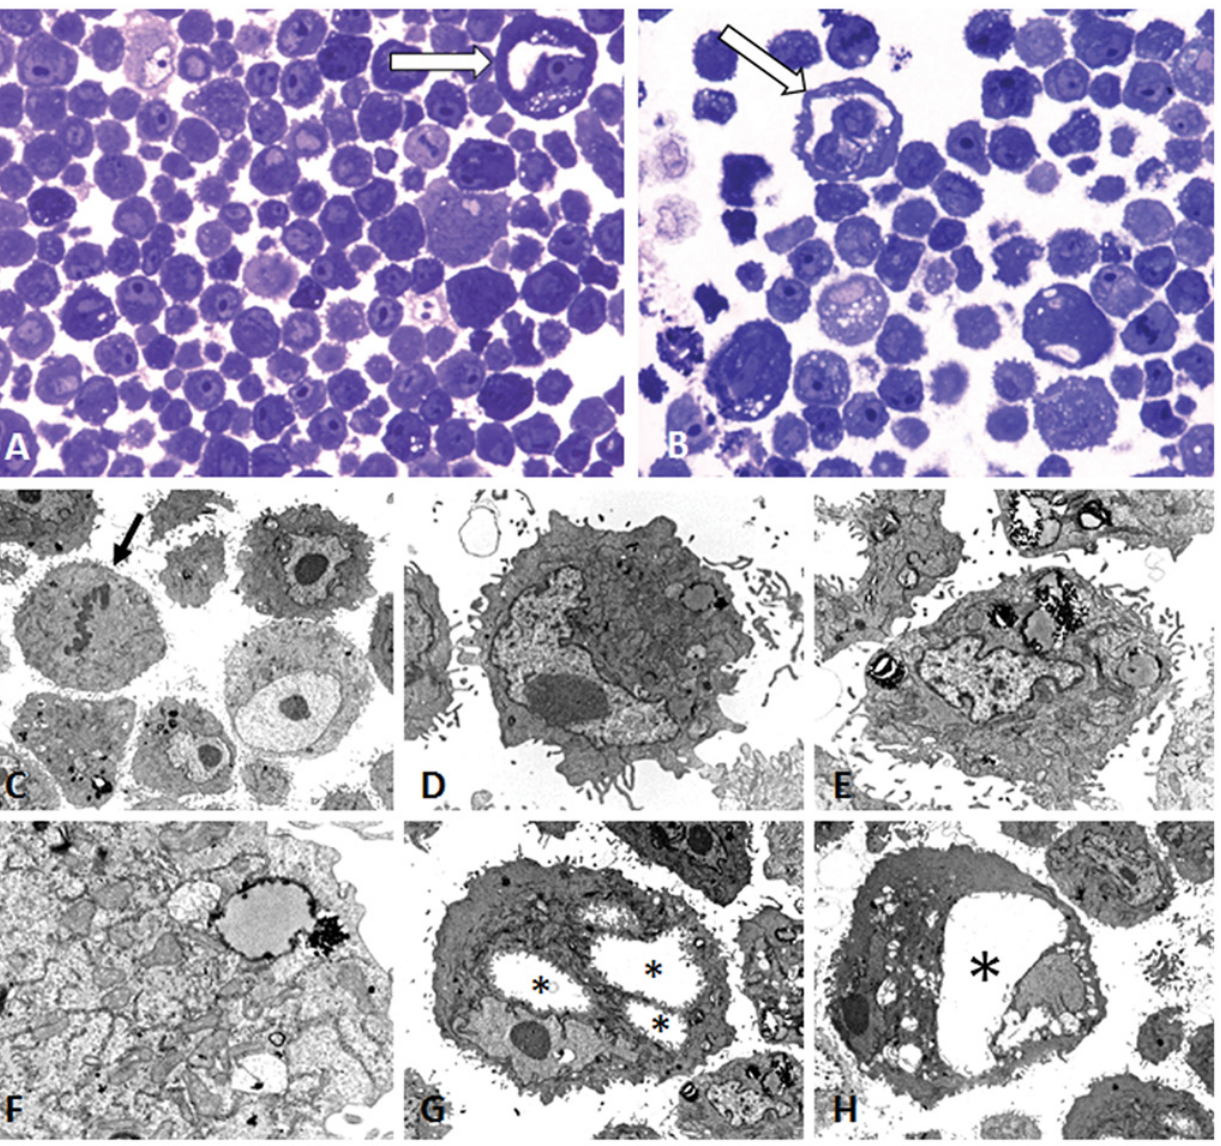
Fig 3. IPC-366 cells in pellet resin sections. A and B) Semithin sections stained with toluidin blue (40X); some endothelial-like cells are observed (arrows). C to H) Ultraestructure in ultrathin sections. C) Cells with large nuclei and evident nucleoli. Mitosis (arrow). D) Single cell with elongated nucleus, very evident nucleolus and numerous organelles, vacuoles and proteinaceous secretion. E) Tumor degenerated cell with shrunken nucleus and abundant proteinaceous secretion. F) Cytoplasm of a tumor cell containing numerous organelles (mitochondria, endoplasmic reticulum) and a secretory vacuole. G) Tumor cell with three cytoplasmic empty spaces (asterisks) covered by cytoplasmic membrane; progression to a cytoplasmic “ lumen ” characteristic of endothelial-like cells. Evident nucleolus. H) Binucleate tumor cell with a cytoplasmic central empty space ( “ lumen ” , asterisk) (ELC) resembling a capillary vessel (vasculogenic mimicry). Figs. E and G show different fields from the same grid. At 25 th passage, cells were cryogenic storage (-180°C). Re-cultured thawed cells presented similar growth and morphological characteristics with a viability of 95 – 99%. The doubling time of IPC-366 cells at 30 th passage was approximately 24 hours and the cells reached a plateau on day 6 (Fig.